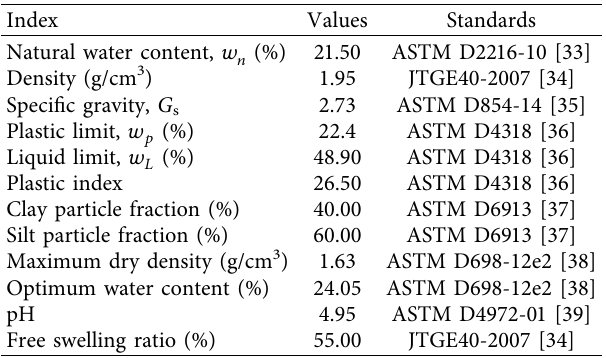
Table 1: Basic physicochemical properties of the tested soil used in this study.